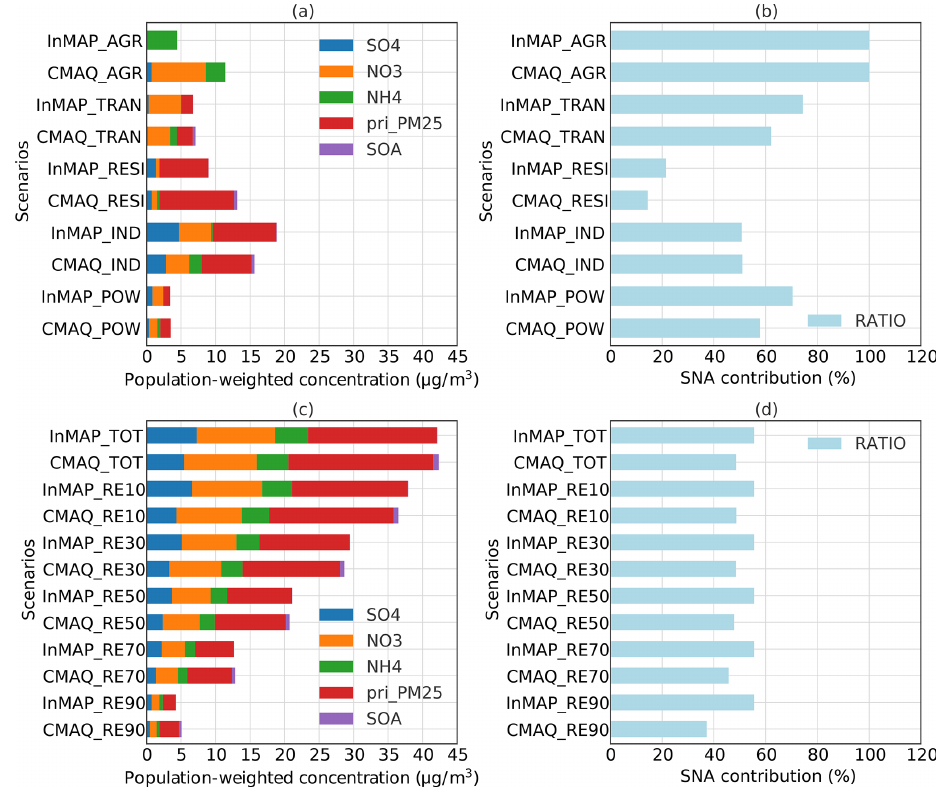
Figure 7. Comparison of PM 2 . 5 component concentrations and SNA contributions in the 11 simulations. Panels (a) and (c) show the modeled PM 2 . 5 compositions: panel (a) presents the results of sectoral emission scenarios, and panel (c) presents the results of the baseline and emission abatement scenarios. Panels (b) and (d) present the SNA contribution (%) for each scenario.